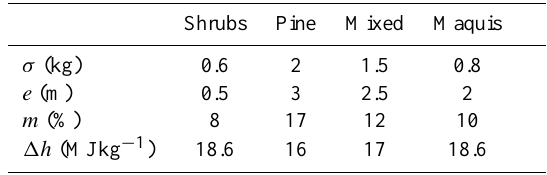
Table 1. Values of the parameters for main fuel types. Shrubs Pine